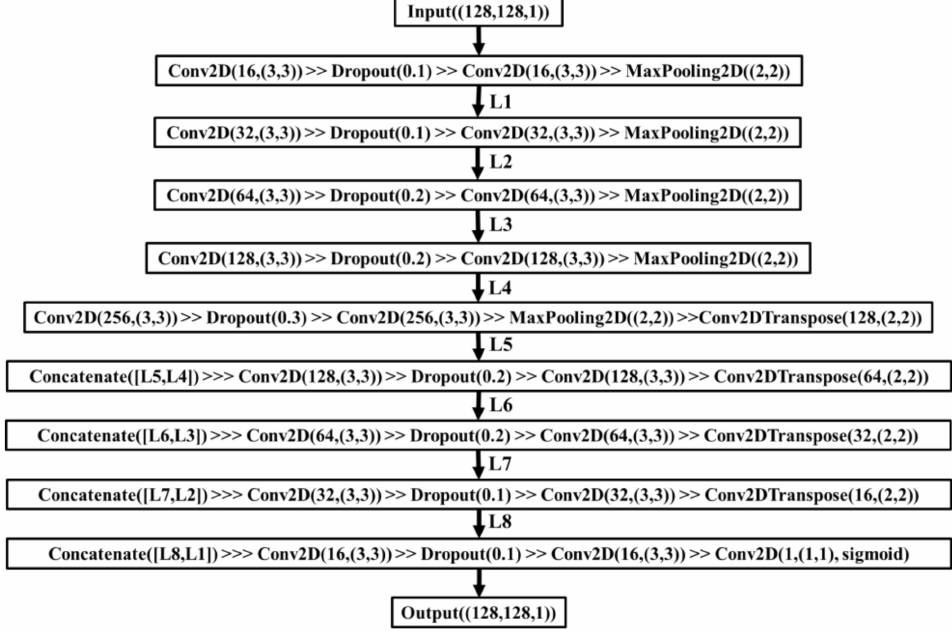
Figure 2. The model architecture of the modified U-Net used in this